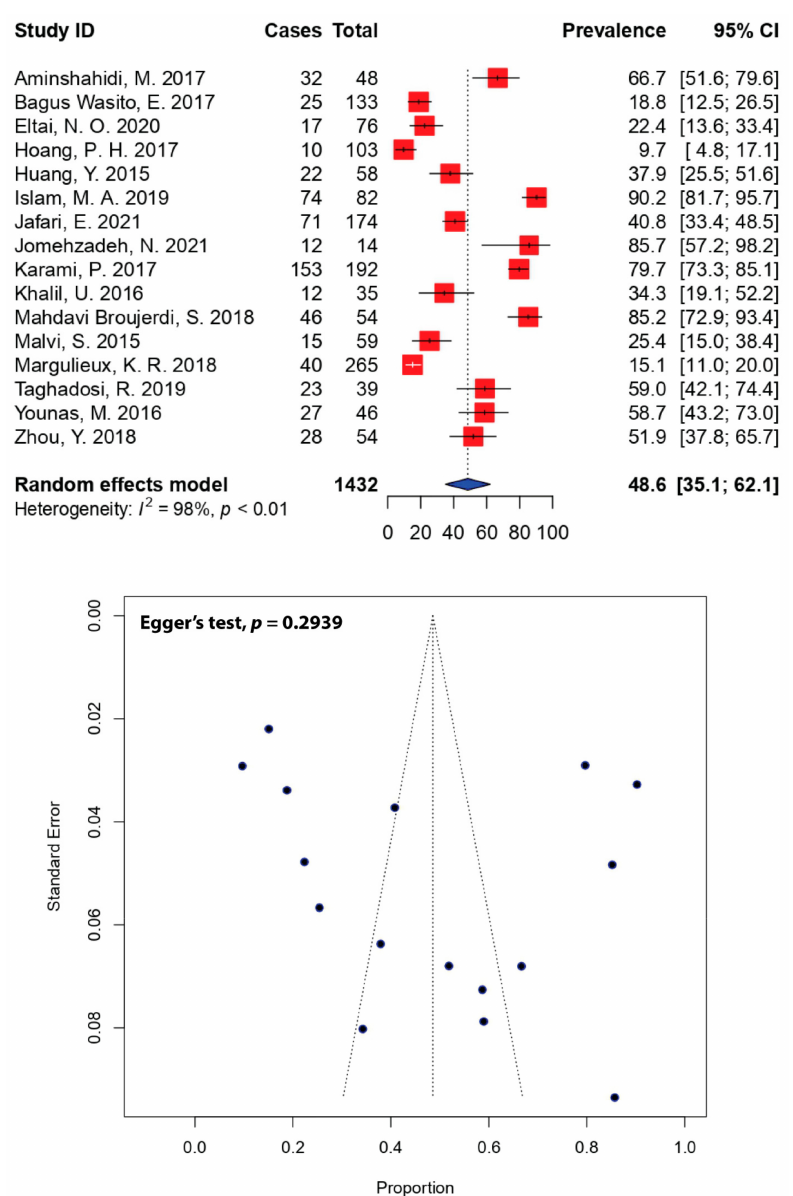
Figure 5. Forest and funnel plots representing the pooled prevalence of extended-spectrum β - lactamase (ESBL)-producing DEC in Asia. The estimate of prevalence was calculated by pooling 16 selected studies using the random-effects model (top panel). The distribution of effect estimates is shown by a funnel plot (bottom panel). Figures were generated using R